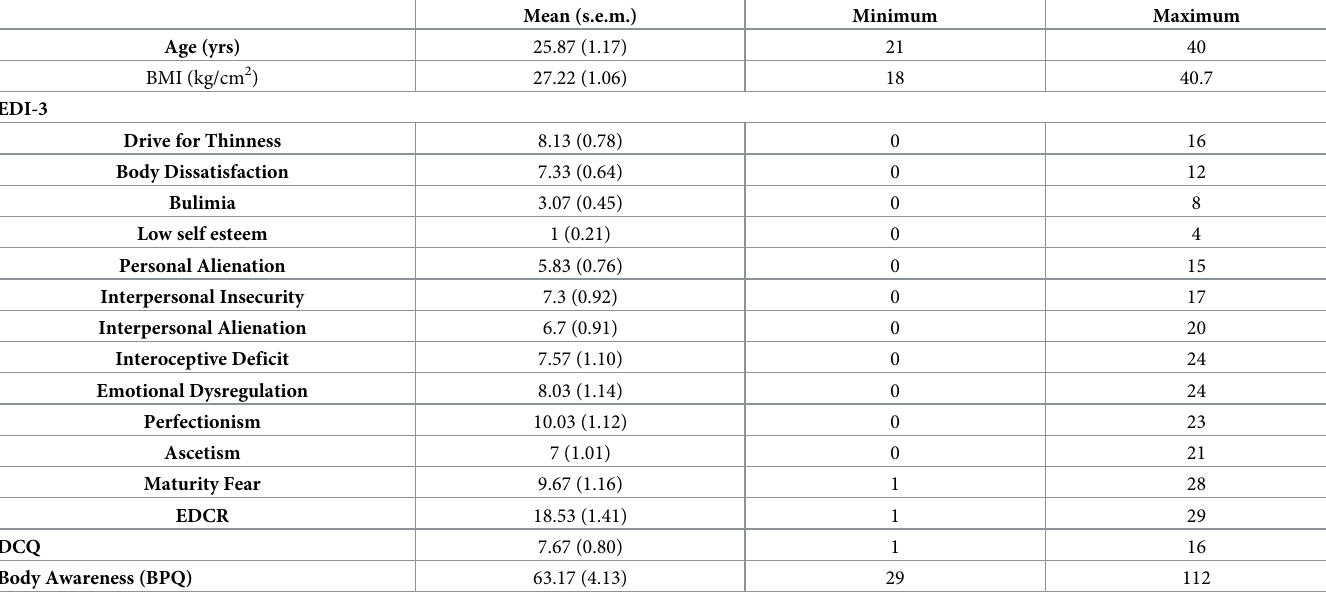
Table 1. Participants’ means and standard error of means (S.E.M. in brackets) of demographic variables and self-report questionnaire scores. Mean